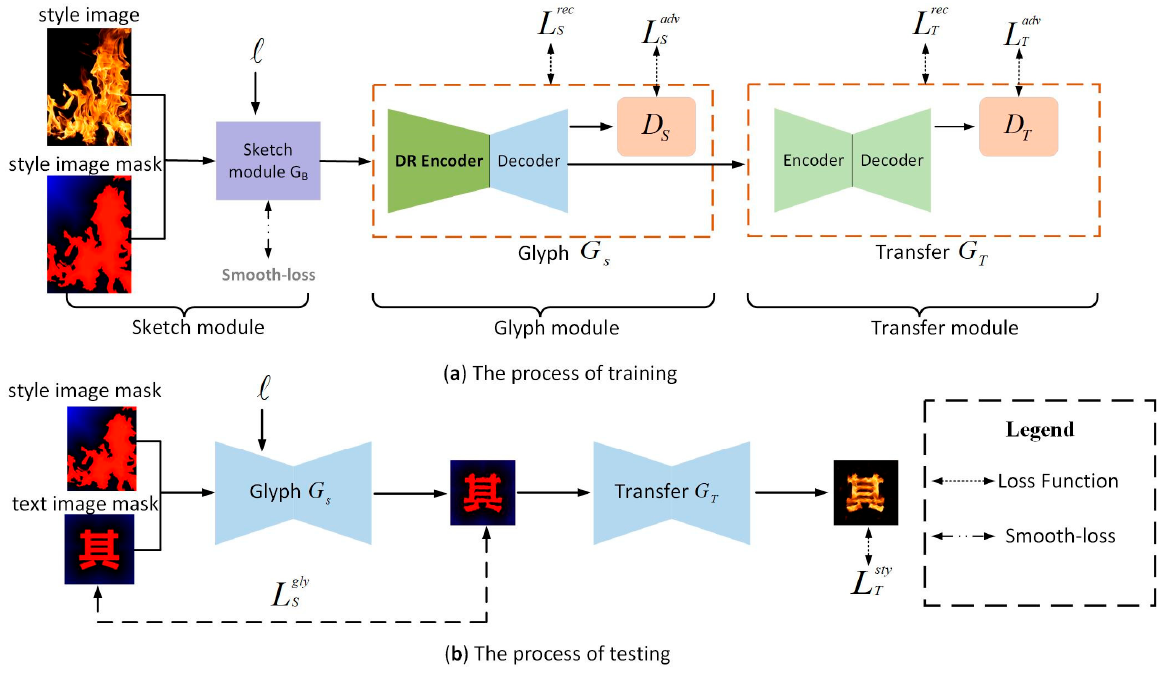
Figure 1. Architecture of the deep deformable artistic font style transfer network.